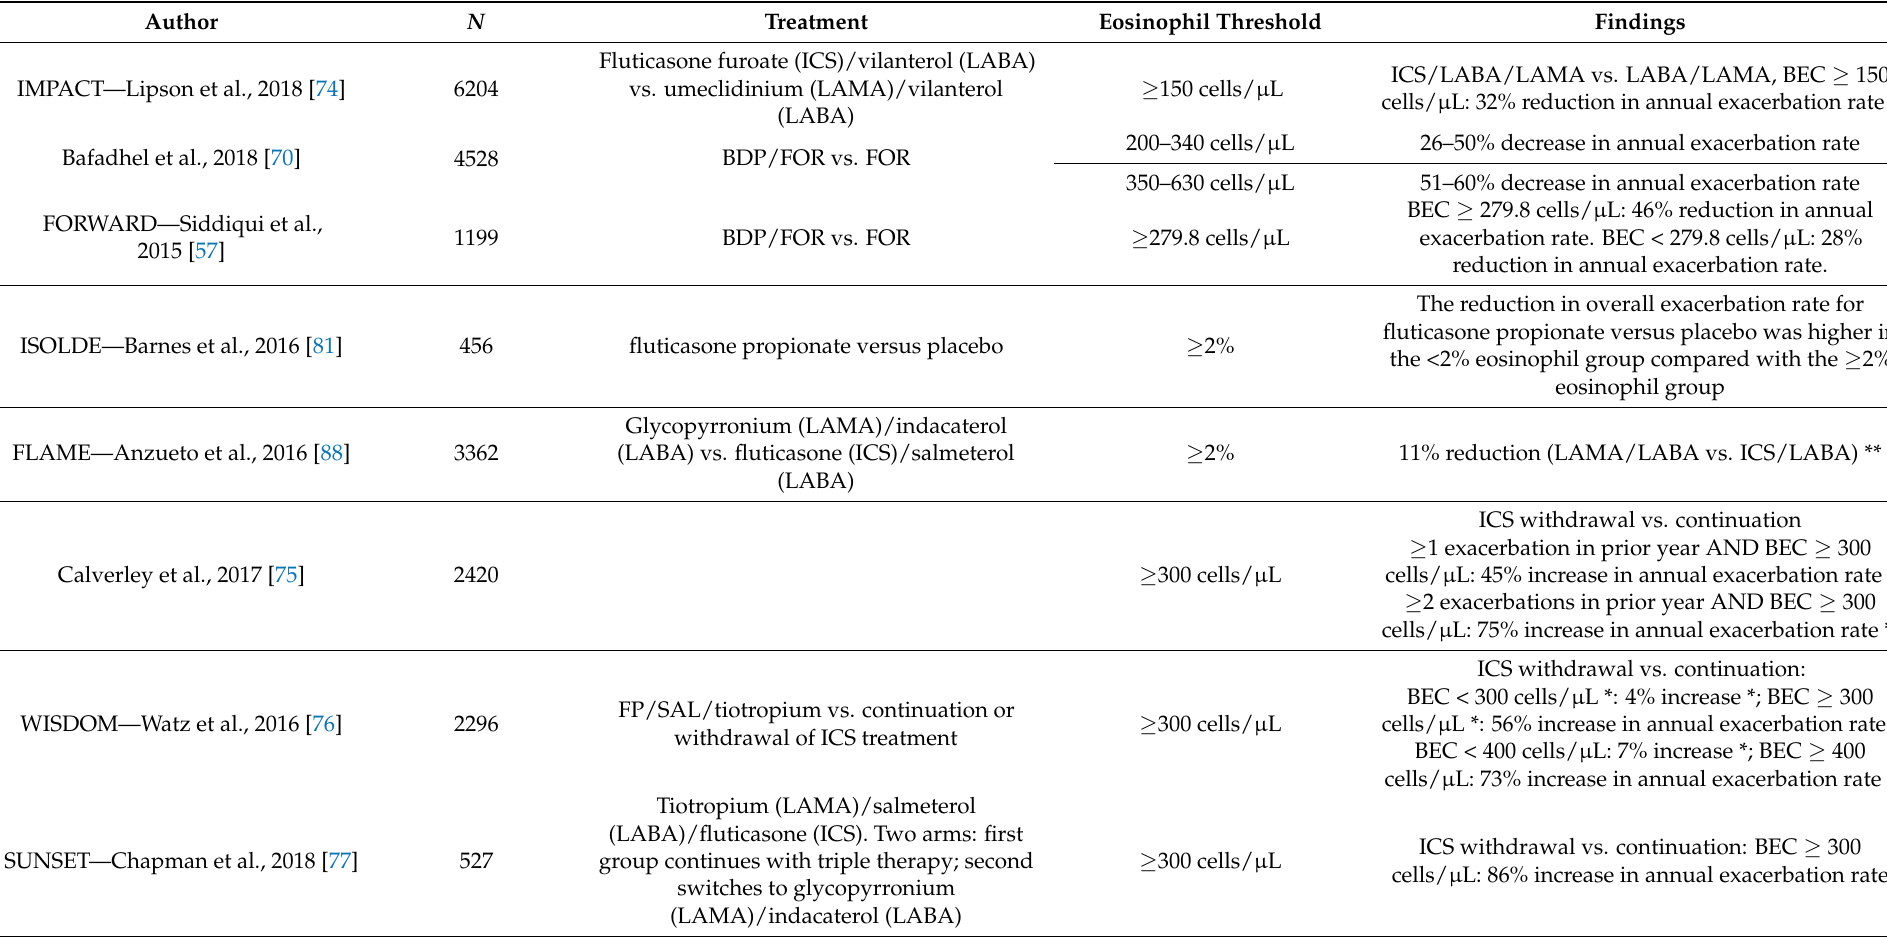
Table 1. Eosinophil thresholds used to identify systemic and inhaled corticosteroid–responsive COPD exacerbations in recent COPD clinical